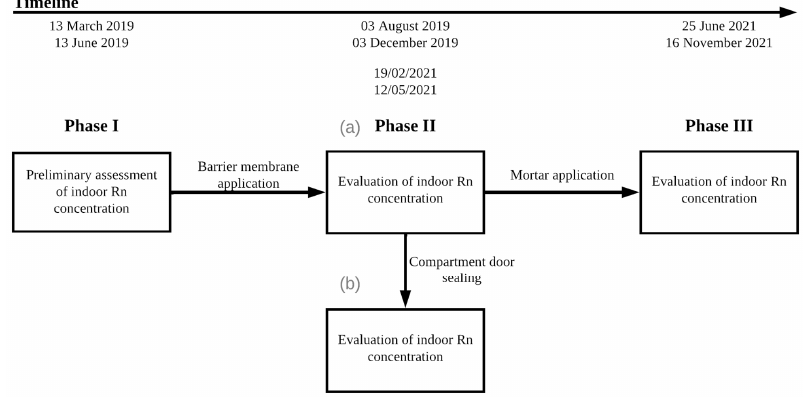
Figure 3. Organization of the works carried out during the monitoring process of the indoor Rn concentration in the compartment selected for the present case study.